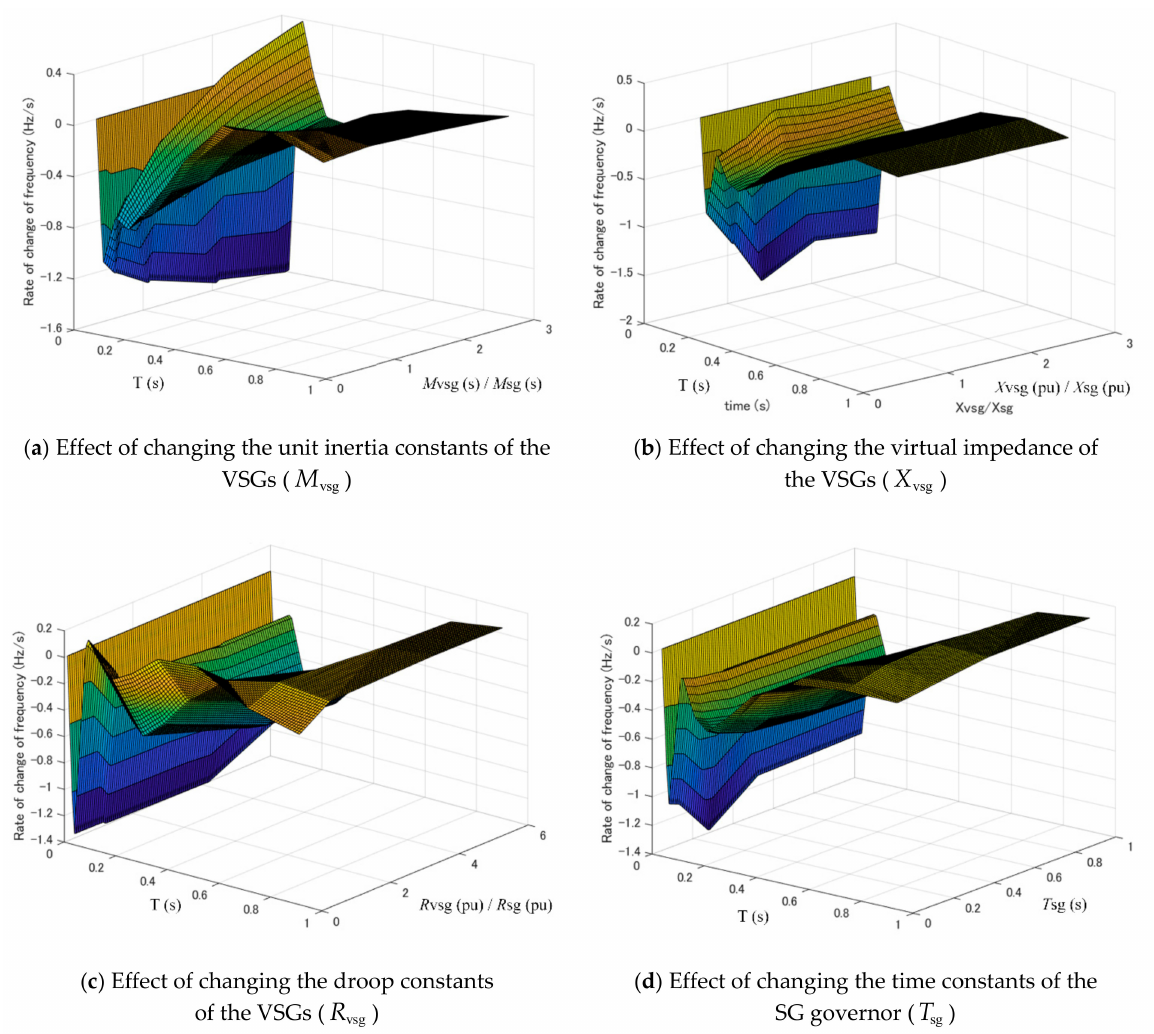
Figure 11. Variation in the rate of change of the frequency (RoCoF) of the center of inertia of the system for various generator